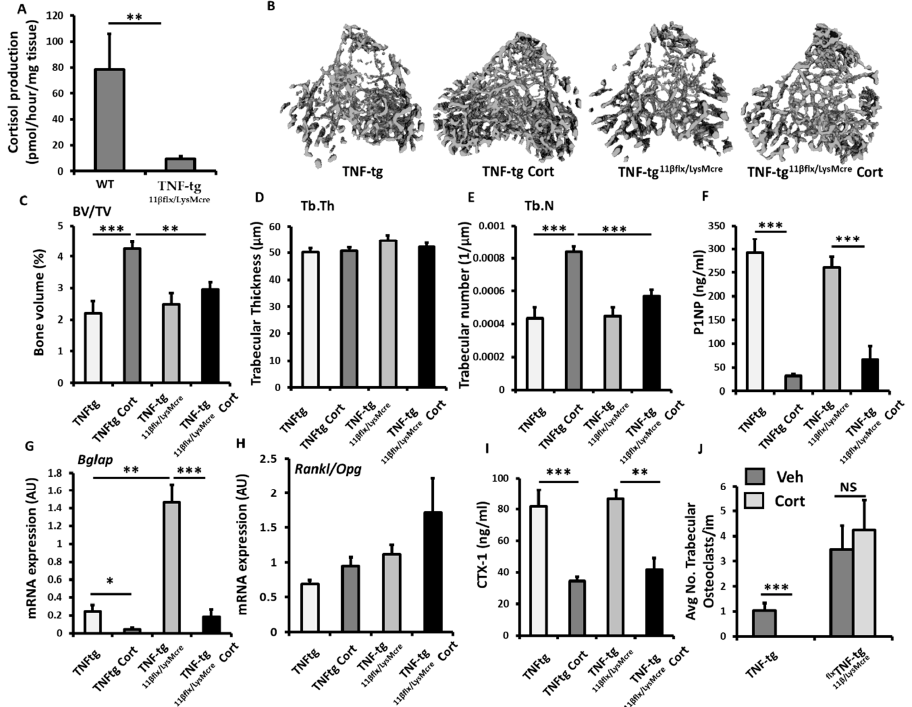
Figure 5. ( A ) Glucocorticoid activation by 11 β -HSD1 over 24 h in primary bone marrow derived osteoclast cultures isolated from wild type, and TNF-tg 11 β flx/LysMcre animals determined by scanning thin layer chromatography. ( B ) Representative images of 3D reconstructions of tibia trabecular bone using micro-CT, ( C ) bone volume to tissue volume (BV/TV), ( D ) trabecular thickness (Tb.Th) and ( E ) trabecular number (Tb.N) determined by Meshlab software analysis of micro CT in TNF-tgand TNF-tg 11 β flx/LysMcre animals receiving either vehicle (Veh) or corticosterone (Cort) (100 µ g/mL) in drinking water over 3 weeks. ( F ) Serum P1NP (ng/mL), mRNA expression (AU) of ( G ) Bglap mRNA expression (AU), ( H ) RankL/Opg mRNA ratio and ( I ) serum CTX-1 (ng/mL) in TNF-tg and TNF-tg 11 β flx/LysMcre animals receiving either vehicle or corticosterone (100 µ g/mL) in drinking water over 3 weeks determined by either RT-qPCR or ELISA. ( J ) Average number of osteoclasts normalised to trabecular bone perimeter (N.Oc/Pm (mm) in TNF-tg and TNF-tg 11 β flx/LysMcre animals receiving either vehicle or corticosterone (100 µ g/mL) in drinking water over 3 weeks determined using Image J analysis software following TRAP staining. Values are expressed as mean ± standard error of six animals, or 3 primary cell cultures per group. Statistical significance was determined using two-way ANOVA with a Tukey post hoc analysis. * p < 0.05, ** p < 0.005 and *** p <